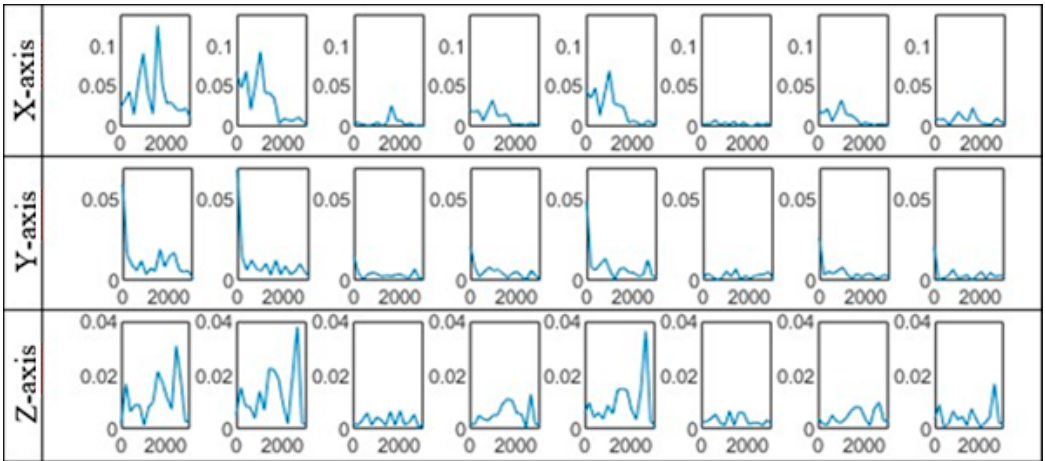
Figure 6. Kernels of first convolutional layer.